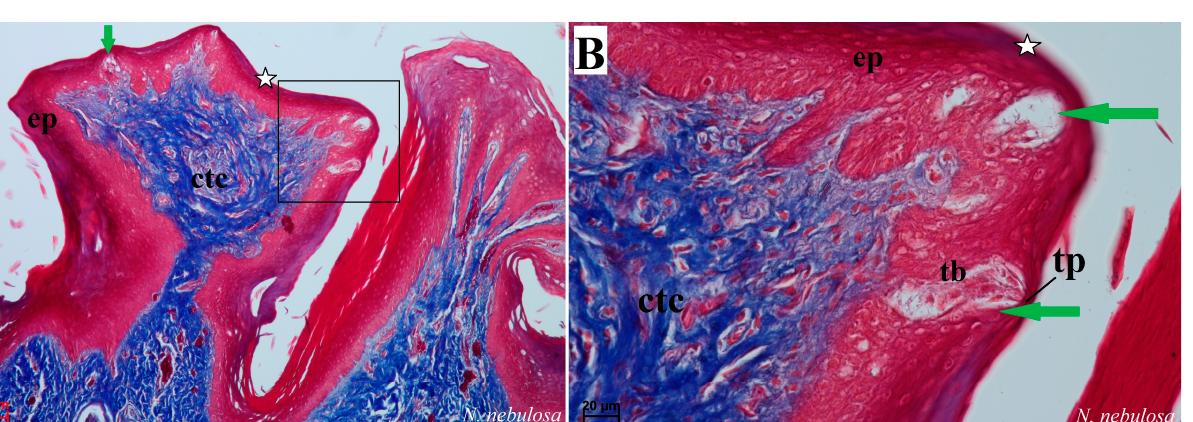
Figure 8. Histological structure of the filiform papillae of the tongue of the four undomesticated species of Felidae: N. nebulosa ( A , B ), P. leo bleyenberghi ( C , D ), O. manul ( E – H ) and L. lynx (I). ( A ) Longitudinal section of the filiform papillae with well-defined stratum granulosum and stratum corneum of the papillary stratified squamous epithelium. ( B ) Longitudinal section of the filiform papillae with interpapillary epithelium. ( C , F ) Rostral view of the filiform papillae. ( D , E – I ) Longitudinal section of the filiform papillae with the enlarged stratum granulosum. Azan trichrome staining ( A , F , G , H ); Masson–Goldner trichrome staining ( B , C , E ); H&E staining ( D , I ). Bar = 200 µm (A,F); bar = 100 µm (B,C,D,G); bar = 50 µm (E,H,I). Abbreviations: ant—anterior part of the filiform papillae (prominent stratum granulosum), ctc—connective tissue core, ep—epithelium, Fi—filiform papilla, iep—interpapillary epithelium, m—muscle fibers, po—posterior part of filiform papillae (prominent stratum corneum).